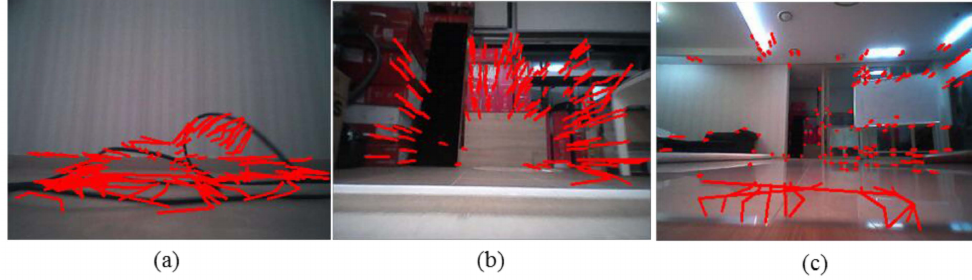
Figure 1. Tracking results for LKT [25] method when robot moves forward with no rotation. ( a ) Tangled wire. ( b ) Windowsill. ( c ) Floor with changing